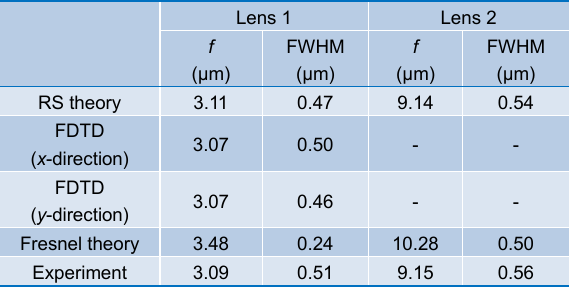
Table 2 | Focal lengths f and FWHMs of the theoretical and experimental results of Lens 1 and Lens